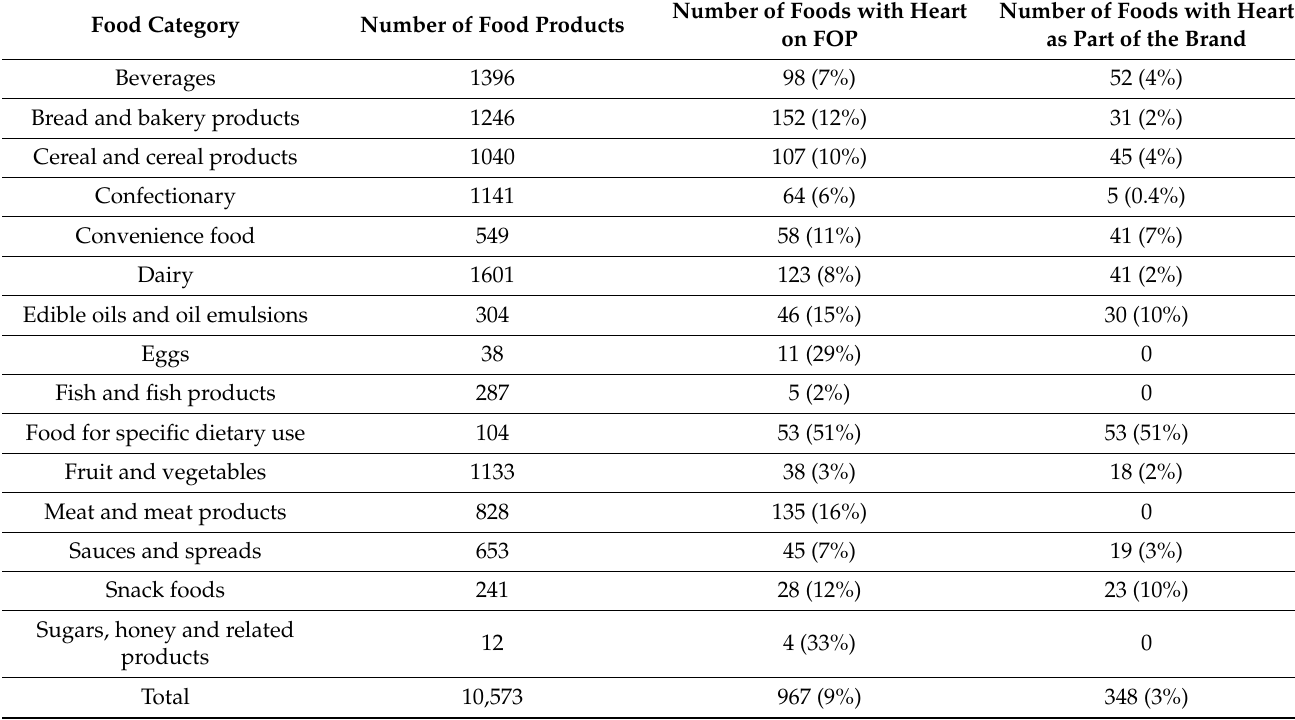
Table 3. Numbers of foods labelled with heart images within different food